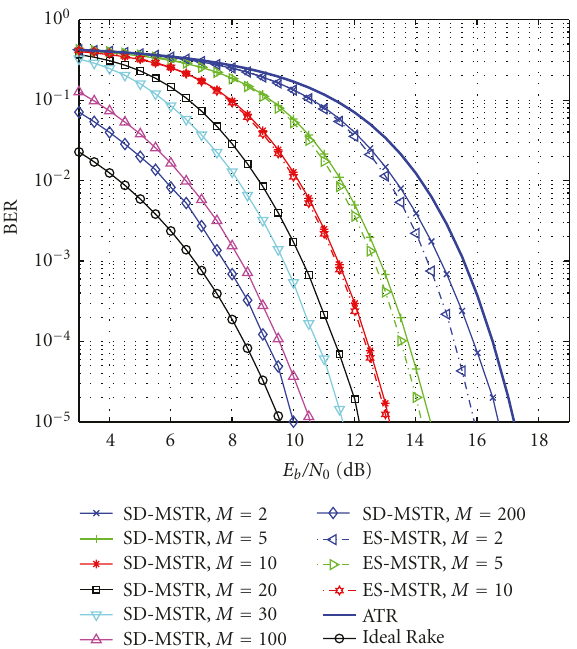
Figure 4: BER of SD-MSTR for di ff erent iterations M = 5, 30, K = 200, N f =